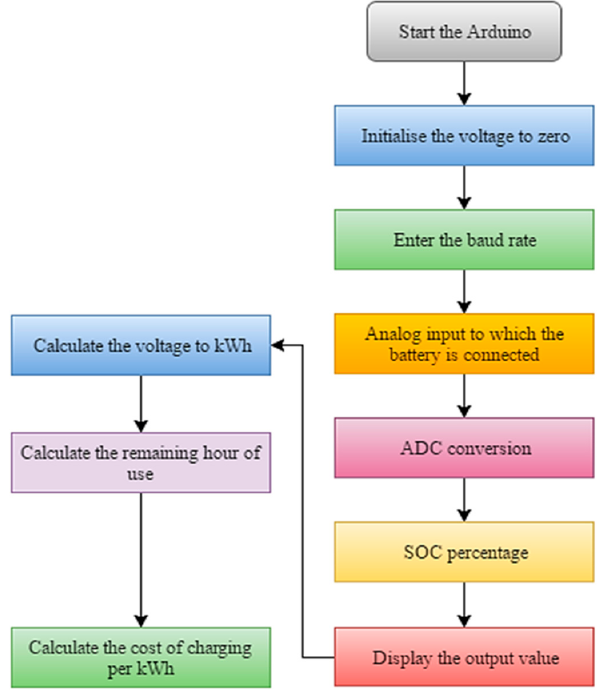
Figure 7. SOC estimation flowchart.